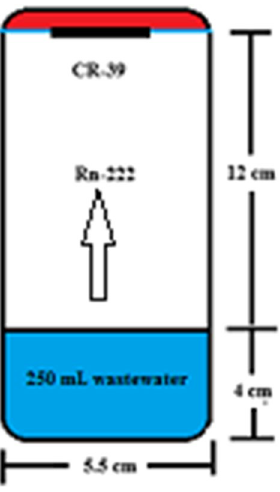
Fig. 2 Sketch of sealed-can